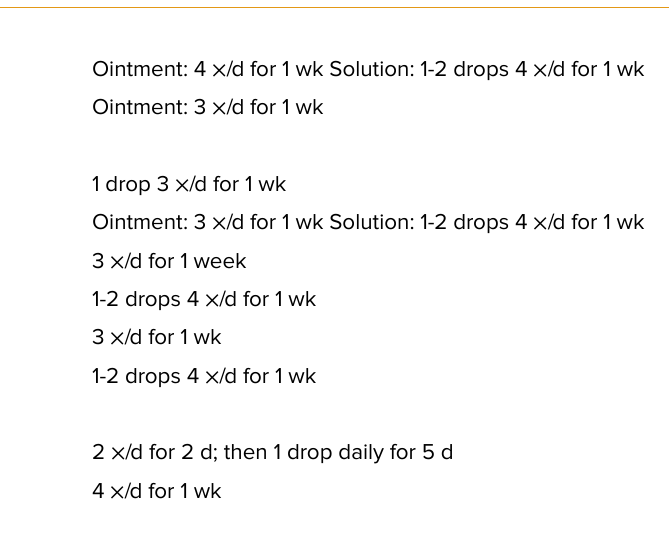
Table 3. Ophthalmic drug therapies for acute bacterial conjunctivitis. Antibiotic agents